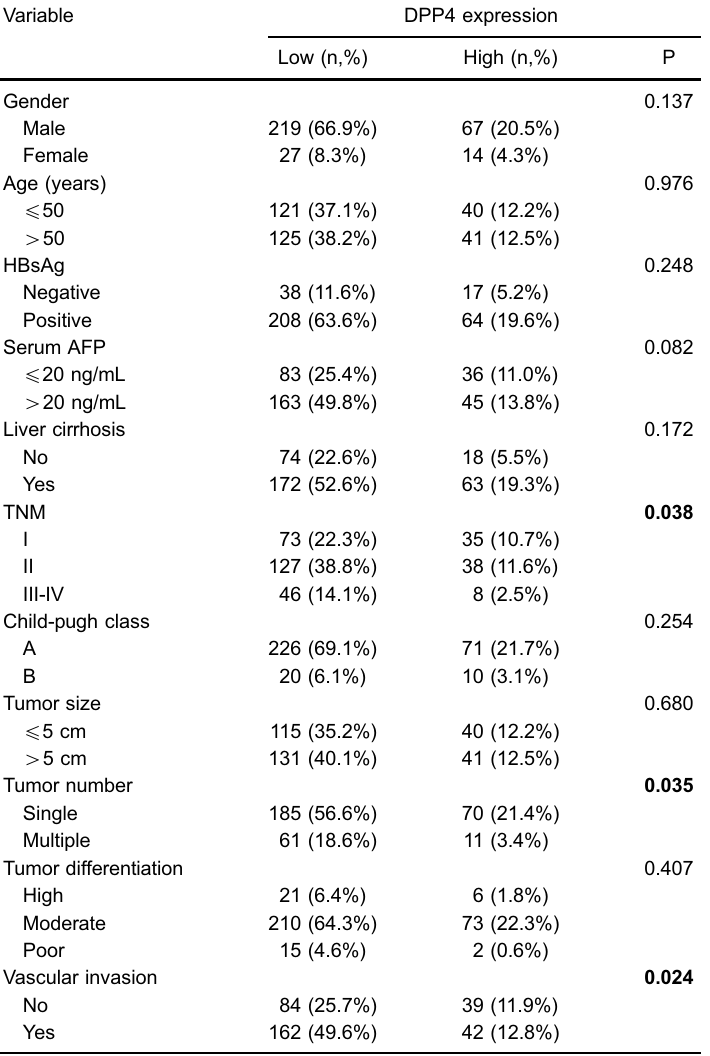
DPP4: dipeptidyl peptidase 4; HbsAg: hepatitis B surface antigen; AFP: alpha fetoprotein; TNM: tumor-node-metastasis. Chi-squared test was used